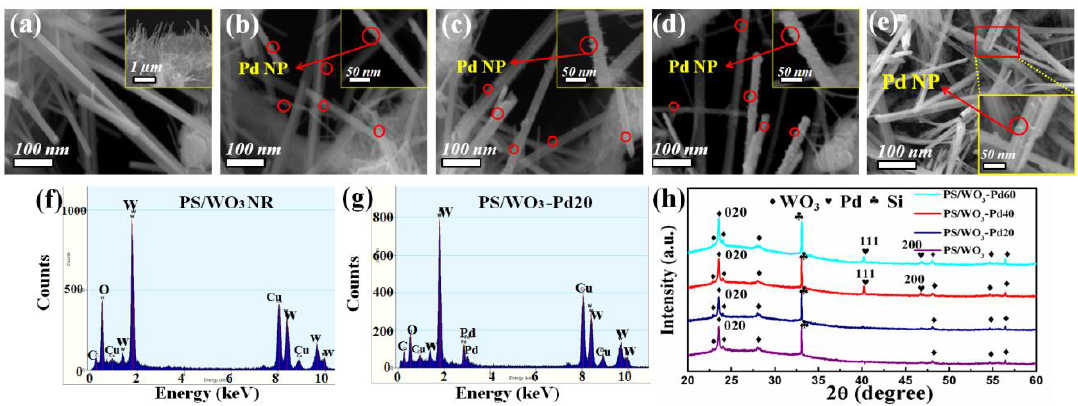
Figure3. High-magnification SEM images of ( a ) PS/WO 3 NRs: top view (inset: cross-section view); ( b ) PS/WO 3– Pd20 (inset: single PS/WO 3 NR–Pd20); ( c ) PS/WO 3– Pd40 (inset: single PS/WO 3 NR–Pd40); ( d ) PS/WO 3– Pd60 (inset: single PS/WO 3 NR–Pd60); and ( e ) Si/WO 3– Pd20; EDS analyses of ( f ) PS/WO 3 NRs; and ( g ) PS/WO 3– Pd20; ( h ) XRD patterns of PS/WO 3 NRs; PS/WO 3– Pd20, PS/WO 3– Pd40, and PS/WO 3– Pd60.